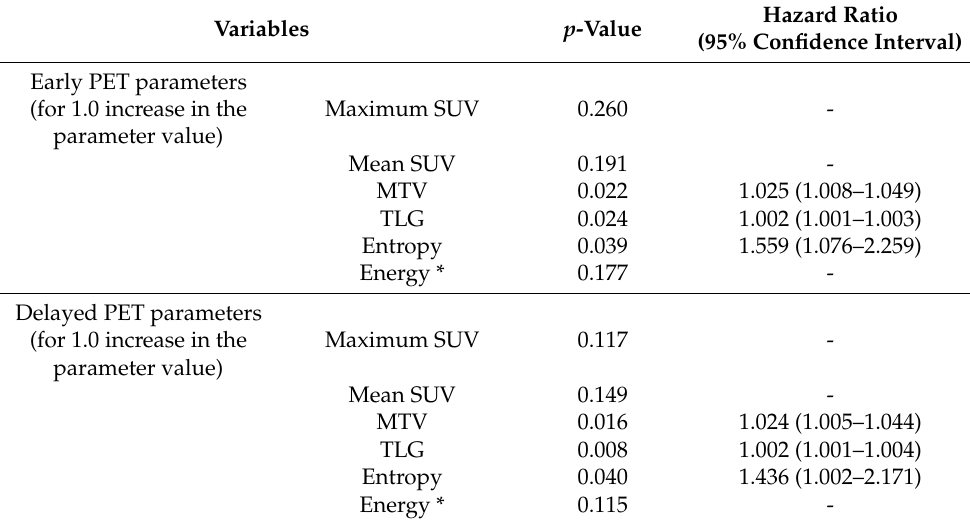
Table 4. Multivariate analysis of dual-time-point PET parameters for predicting PFS in the surgery group (n = 121) after adjustment for age, sex, and TNM stage.